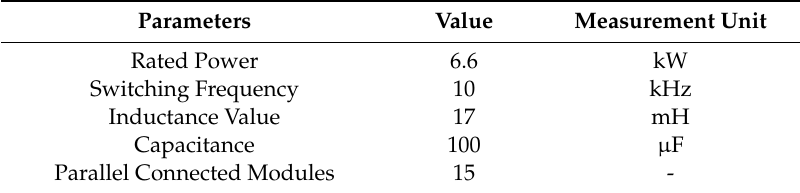
Table A4. Parameters of the EV bidirectional charger.